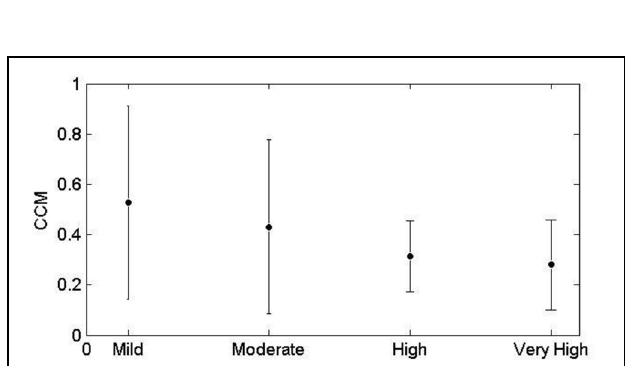
FIGURE 1 | Tone and entropy mean ± SD values for each of the four CVD risk groups.